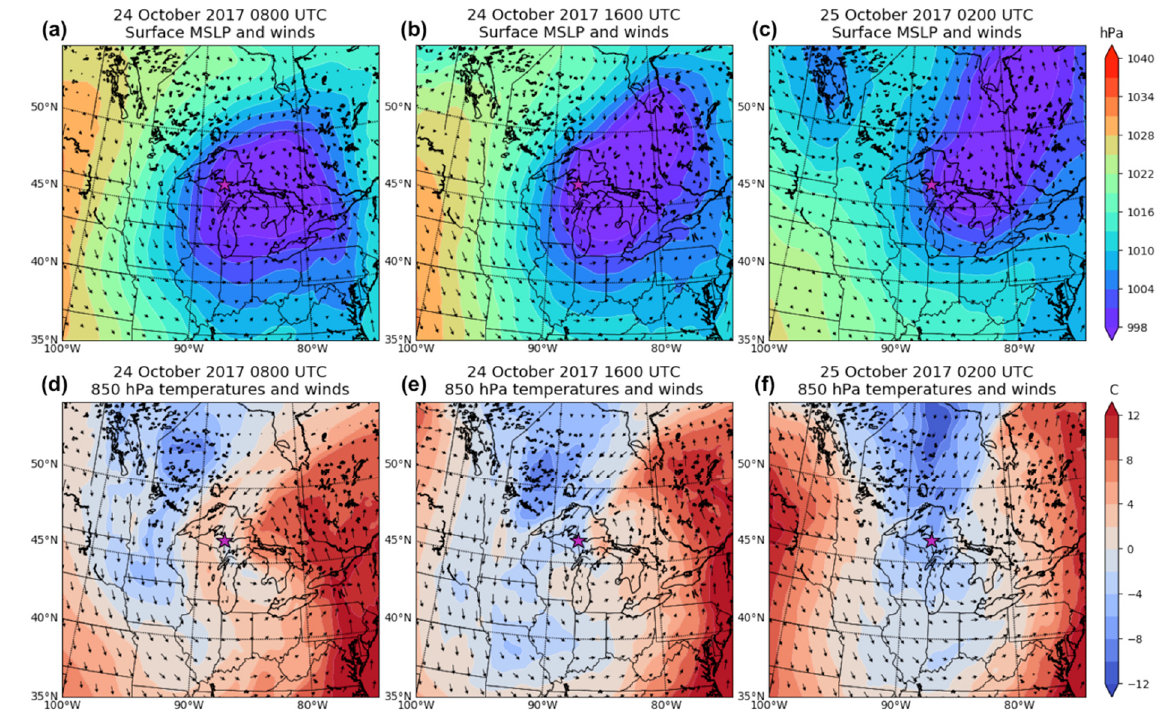
Figure 10. ERA5 MSLP and surface winds and 850 hPa temperatures and winds for 24 October 2017 0800 UTC ( a , d ) and 1600 UTC ( b , e ), and 25 October 2017 0200 UTC ( c , f ).